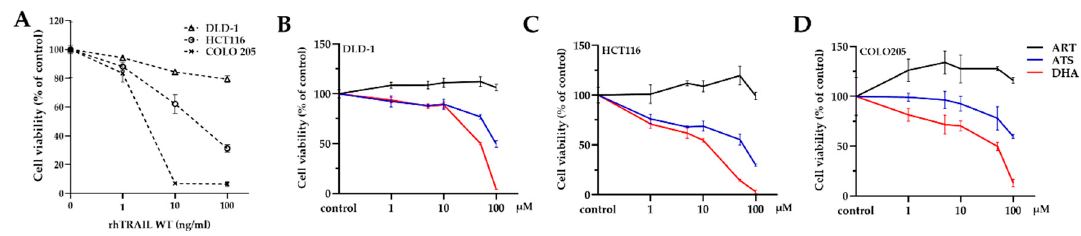
Figure 2. Sensitivity of colon carcinoma cell lines to artemisinin derivatives and rhTRAIL WT treatment. ( A ) The sensitivity of di ff erent colon cancer cells to TRAIL-induced apoptosis; all the cell lines were treated with 0, 1, 10, 100 ng / mL of rhTRAIL WT for 24 h. DLD-1 ( B ), HCT116 ( C ), COLO 205 ( D ) were treated with 0, 1, 5, 10, 50, 100 µ M of ART, ATS / DHA for 24 h. Cell viability was determined by MTS assay. Data shown are mean ± SD from one of at least two independent experiments performed in triplicate.